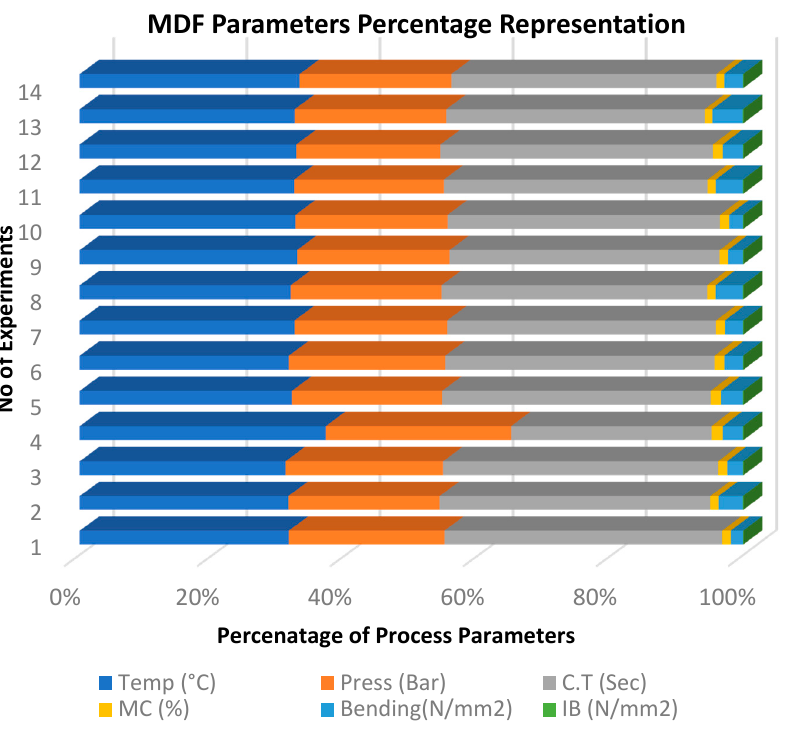
Figure 6. Three-dimensional graphical representation of experiments.